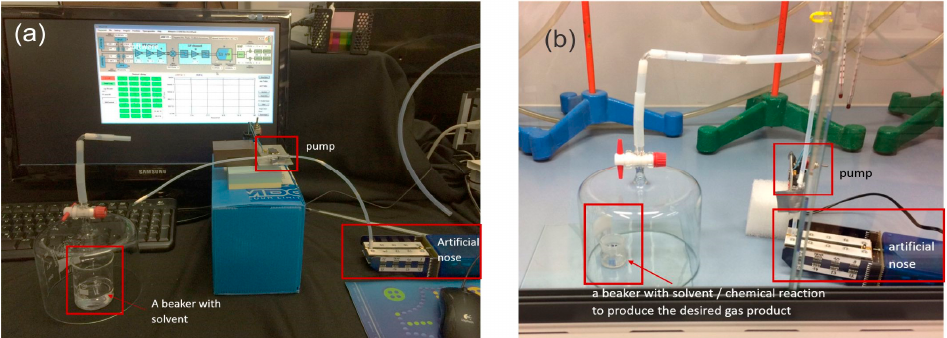
Figure 12. ( a ) The measurement set-up for measuring the response to different solvents in ambient air of the laboratory. ( b ) The set-up for measuring e-nose response to toxic gases in a fume cupboard.